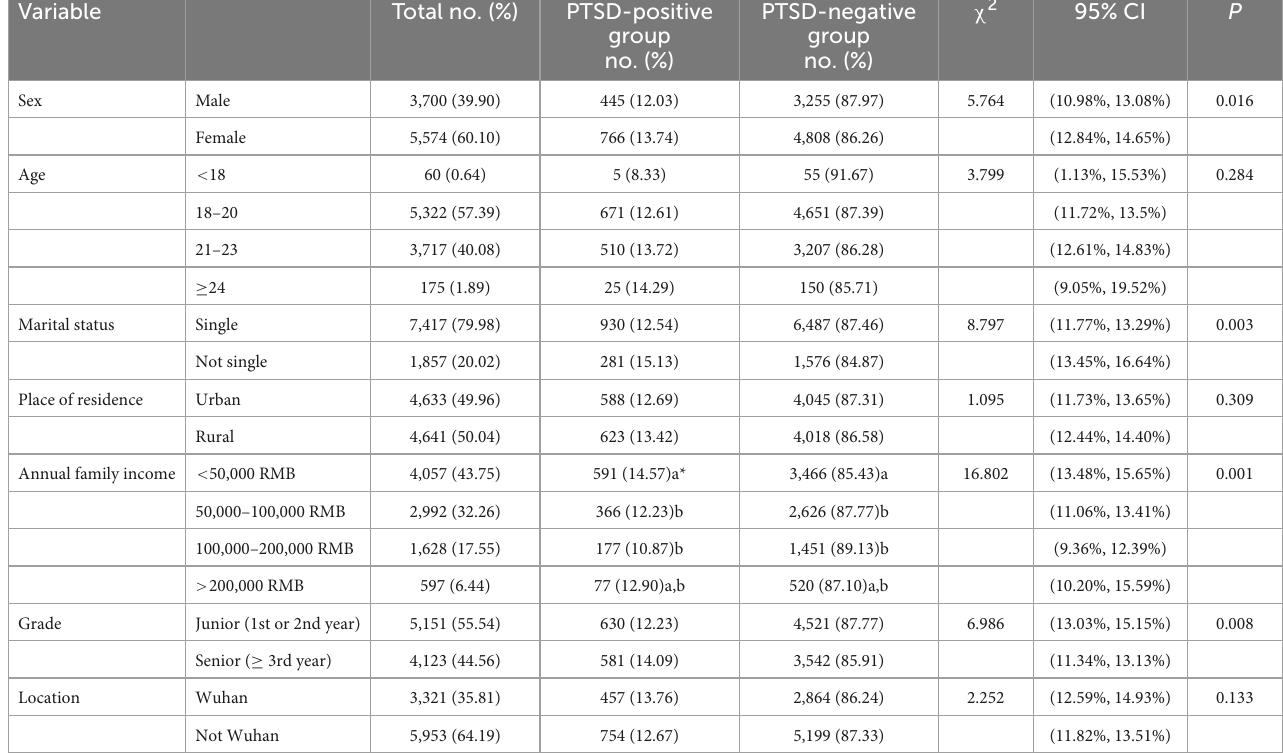
TABLE 3 Differences in demographic variables between the PTSD symptoms positive group and PTSD symptoms negative group. Variable Total no.